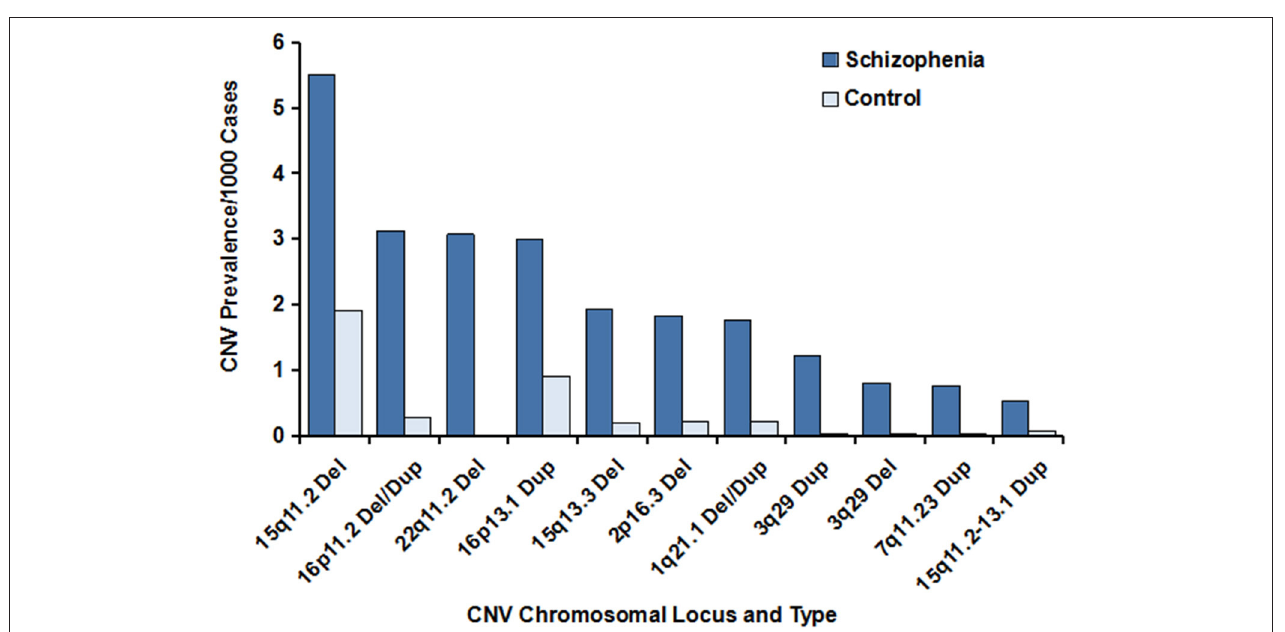
FIGURE 1 | Prevalence of the major CNVs associated with schizophrenia. The data were generated from previous studies, and the references are cited in Table 1 . The prevalence of the major CNVs in individuals with schizophrenia vs. controls is illustrated, with the deletion at 15q11.2 being the CNV with the highest frequency. Of note, the prevalence of the deleted schizophrenia-associated CNV at 22q11.2 in the unaffected control individuals was zero. In addition, extremely low frequencies of the CNVs at 3q29 (deletions), 3q29 (duplications), and 7q11.23 (duplications) were observed in controls, compared with schizophrenia